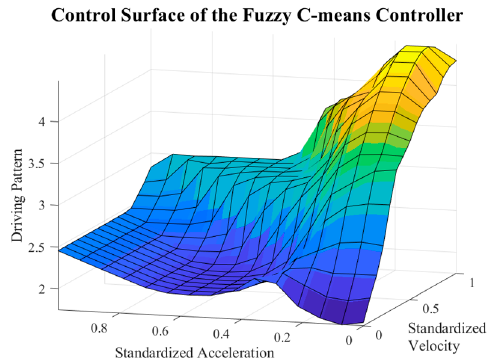
Figure 10. The control surface of the driving pattern recognizer.